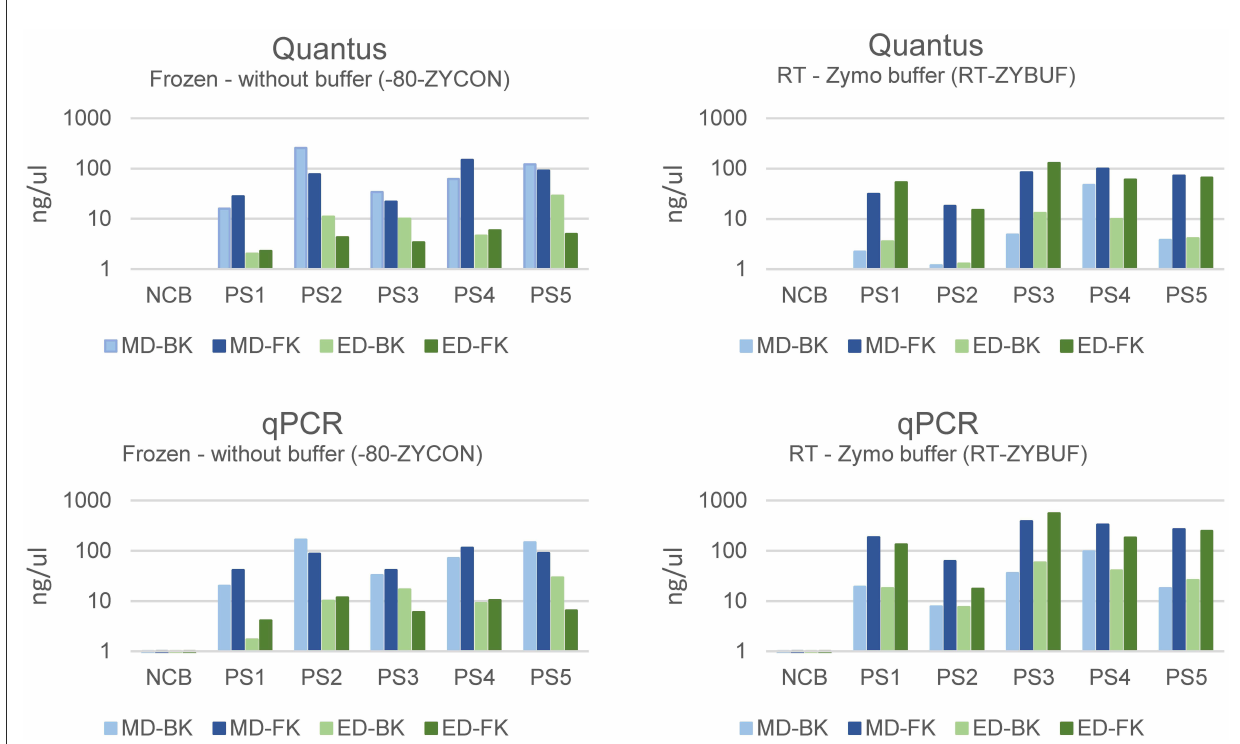
FIGURE6 The bacterial yield of samples using mechanical (MD) or enzymatical disruption (ED) and purified with the Maxwell RSC Blood DNA kit (BK) or the Maxwell RSC Fecal Microbiome DNA kit (FK). The DNA concentration was measured using the Quantus Fluorometer and the bacterial DNA using a universal 16S rRNA gene qPCR and represented in ng/ µ l.